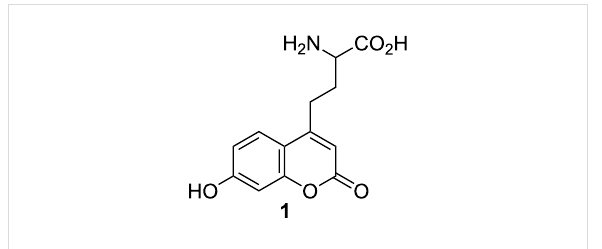
Figure 1: Fluorescent amino acid (7-hydroxycoumarin-4-yl)ethylgly- cine ( 1 ).